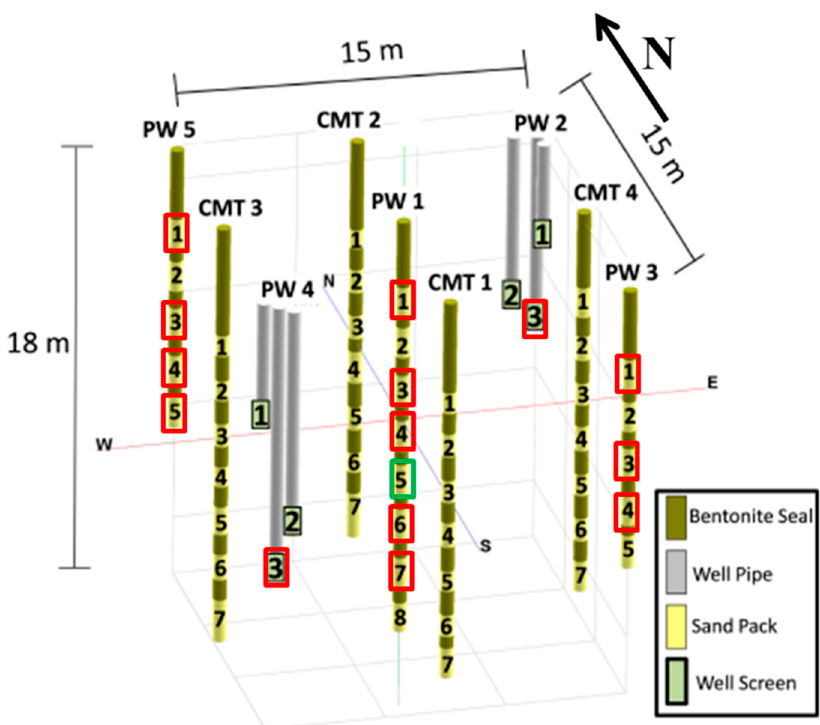
Figure 2. Three-dimensional perspective view of various wells and pumped locations. The red squares are pumped locations to generate drawdown data for model calibration, and the green square indicates the same, but the data are used for model validation (modified after [18]).